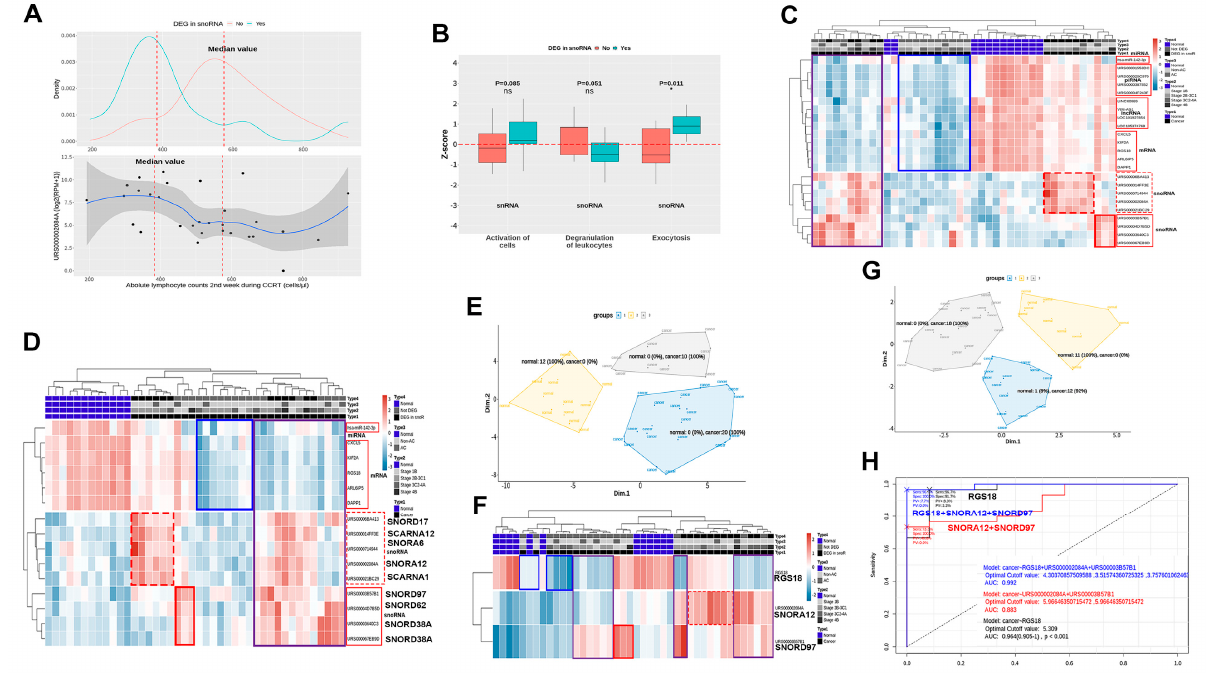
Figure 5. ( A ) Association between the log 2 (RPM+1) value of SNORA12 and the absolute lymphocyte counts in the second week of concurrent chemoradiotherapy according to the DEGs in snoRNA. ( B ) Subcategories that show the difference in Z-scores according to the DEG, in snoRNA in snoRNA or snoRNA. ( C ) An integrated heatmap of one miRNA, four piRNAs, four lncRNAs, five mRNAs, and nine snoRNAs that were selected through the screening process. ( D ) A heatmap and ( E ) a clustered multidimensional scaling (MDS) scatter plot of the combination of one miRNA, five mRNAs, and nine snoRNAs that can distinguish between the normal and cancer groups. ( F ) A heatmap and ( G ) a clustered multidimensional scaling (MDS) scatter plot of the combination of RGS18 , SNORA12, and SNORD97, which can distinguish between the normal and cancer groups. ( H ) Three receiver operative characteristics curves of RGS18 (black), RGS18 +SNORA12+SNORD95 (blue), and SNORA12+SNORD95 (red).